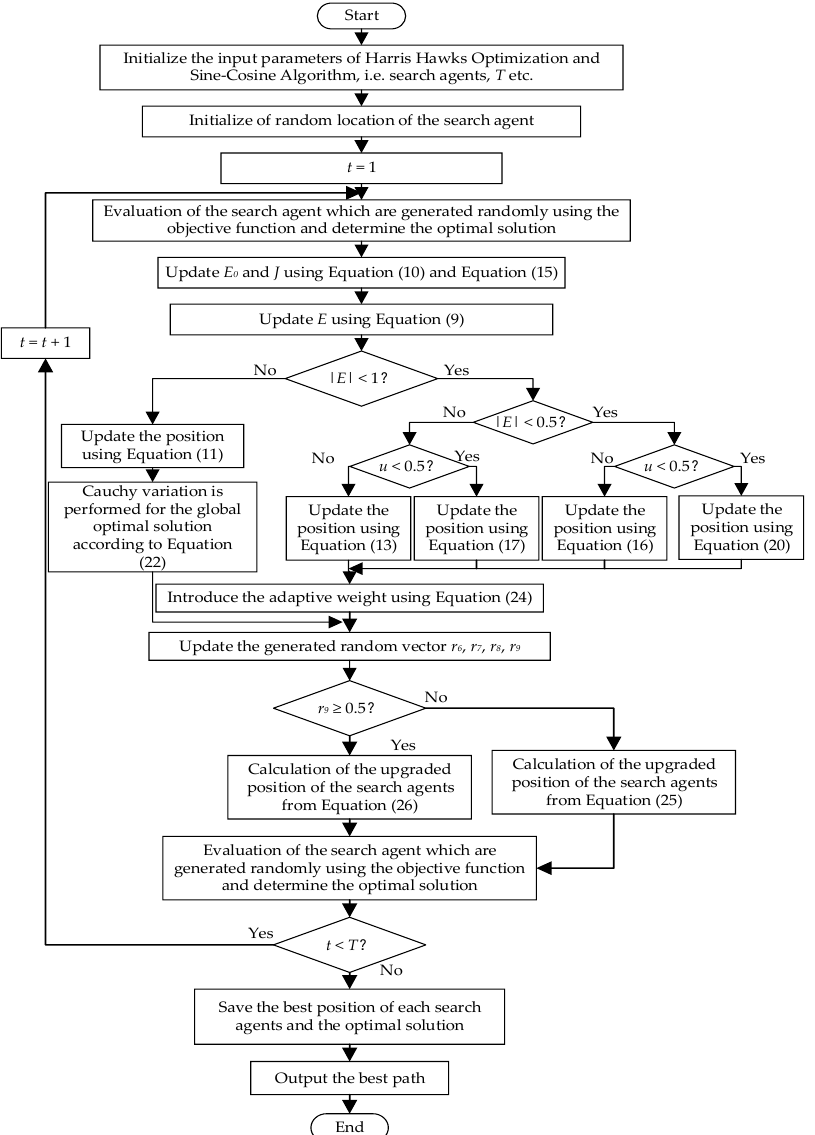
Figure 2. Flowchart of proposed path planning algorithm.